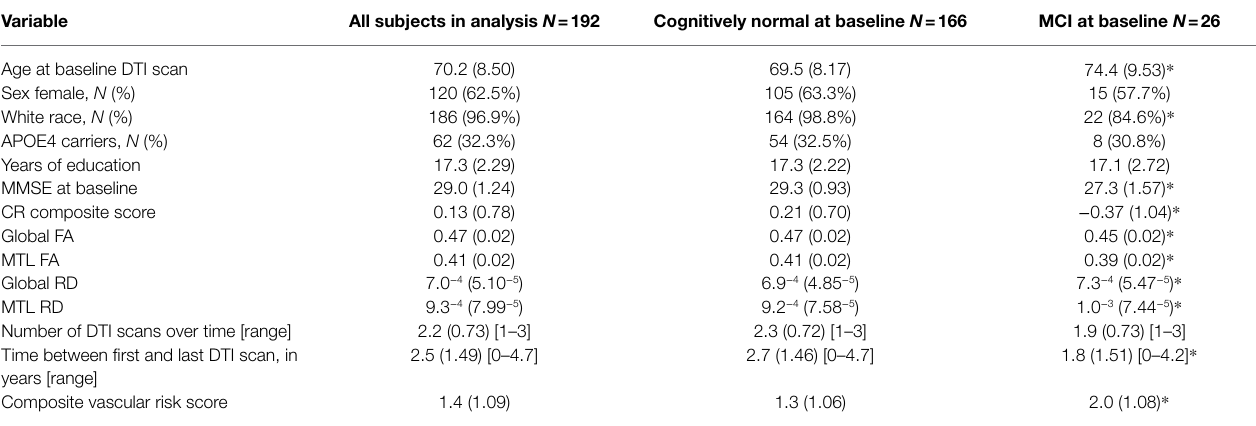
TABLE 1 | Baseline characteristics of participants included in the analyses. Values reflect mean (SD) unless otherwise indicated.